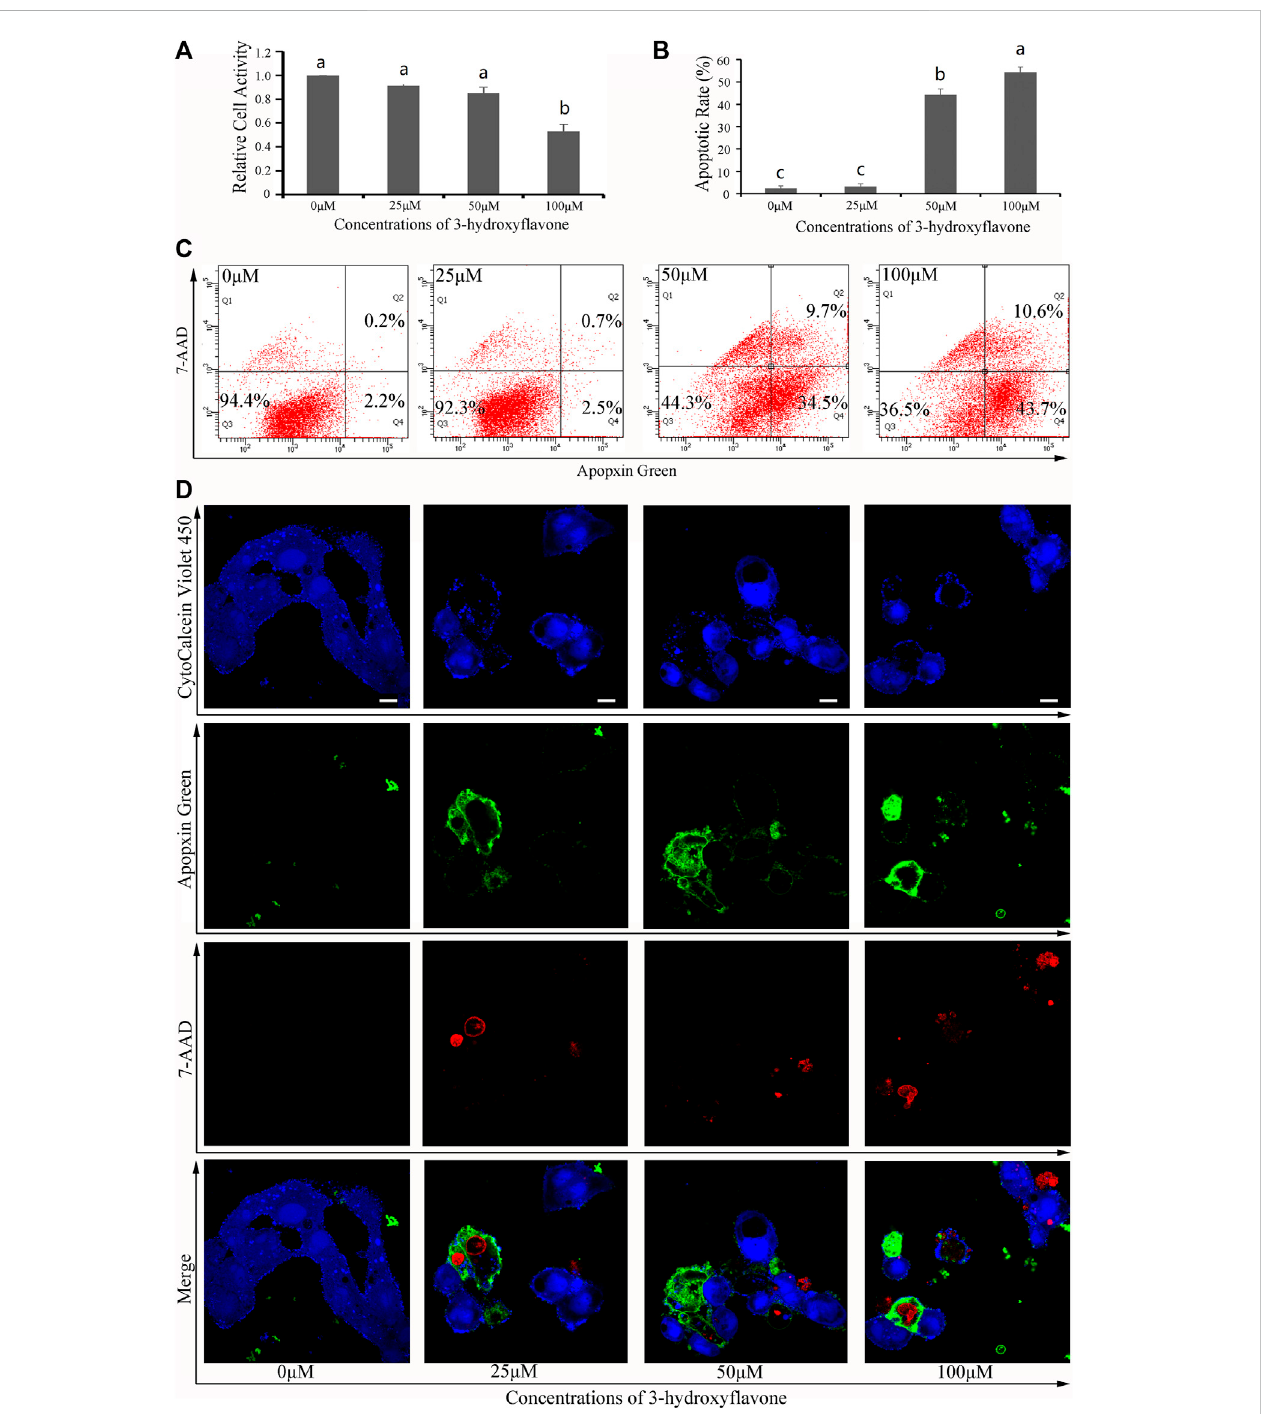
FIGURE 7 Effects of 3-hydroxy fl avone on HepG2 cells. (A) Relative cell activity; (B) Apoptotic rate. Data are expressed as the mean ± SEM ( n = 3). Different small letters indicate extremely signi fi cant differences between two treatments ( p < 0.01). (C) Representative FACS plots of cells treated with different concentrations of CTFs and stained with Apopxin Green and 7-AAD to identify apoptotic cells in the early and late stages, respectively. From left to right, the concentrationofCTFswas0 μ M,25 μ M,50 μ M,and100 μ M.Dataarerepresentativeoffourindependentexperiments. (D) RepresentativeCLSMimages ofHepG2 cells treatedwith different concentrations ofCTFsand stained withCytoCalcein Violet 450(in bluecolor, representing live cells), Apopxin Green(in green color), 7-AAD (in red color). Representative CLSM images of apoptotic HepG2 cells treated with different concentrations of CTFs, CytoCalcein Violet 450 (in blue color, representing live cells), Apopxin Green (in green color), 7-AAD (in red color) and all of three fl uorescence stains (merge). From left to right, the concentration of CTFs was 0 μ M, 25 μ M, 50 μ M, and 100 μ M. Data are representative of four independent